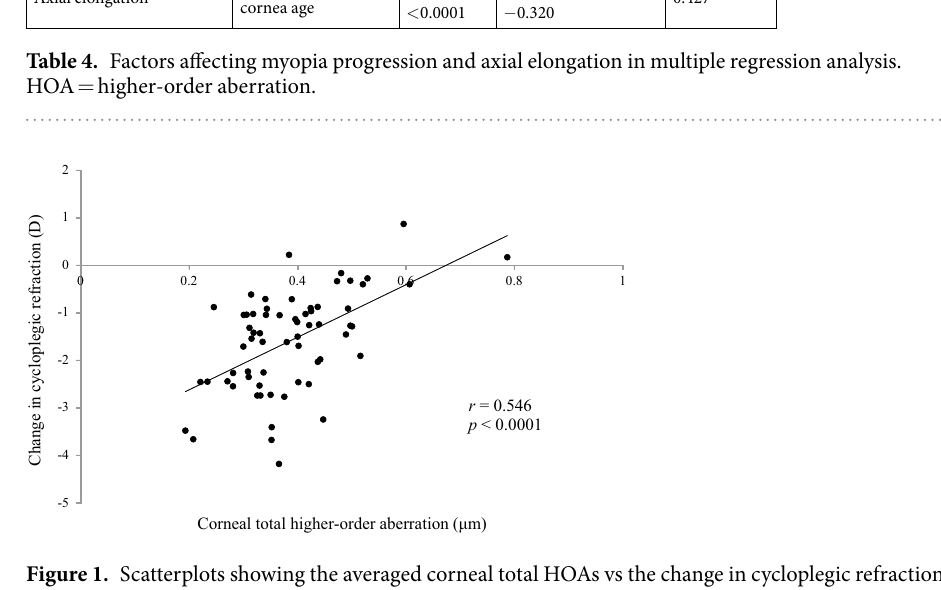
Figure 1. Scatterplots showing the averaged corneal total HOAs vs the change in cycloplegic refraction over 2 years. There was a significant correlation between the parameters (Pearson correlation coefficient; r = 0.546, P < 0.0001), D = dioptre.